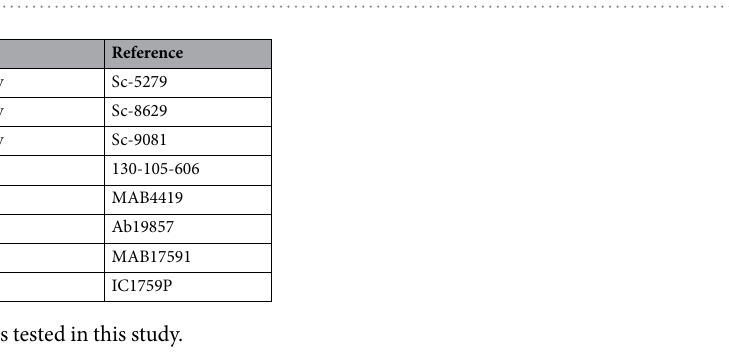
Table 4. List of antibodies tested in this